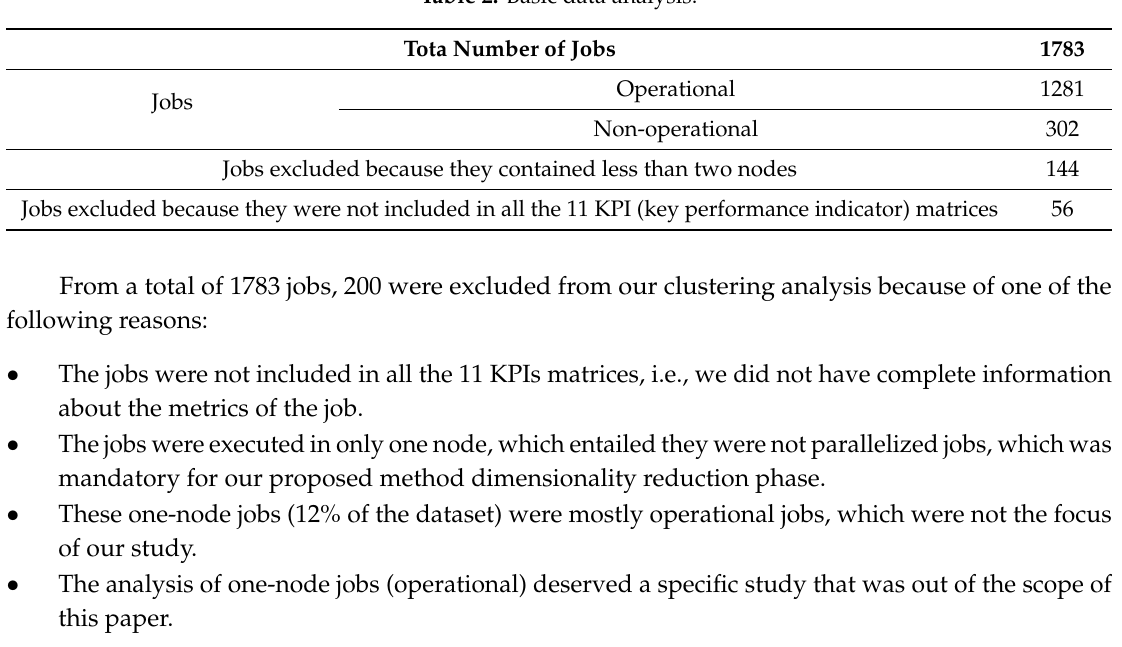
Table 2. Basic data analysis.